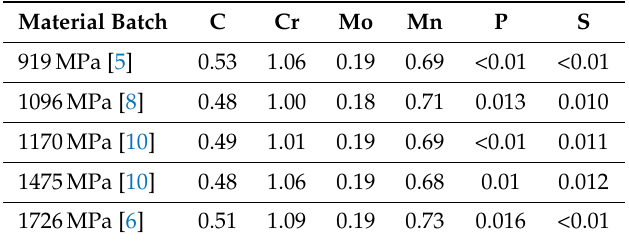
Table 1. Chemical composition (in weight